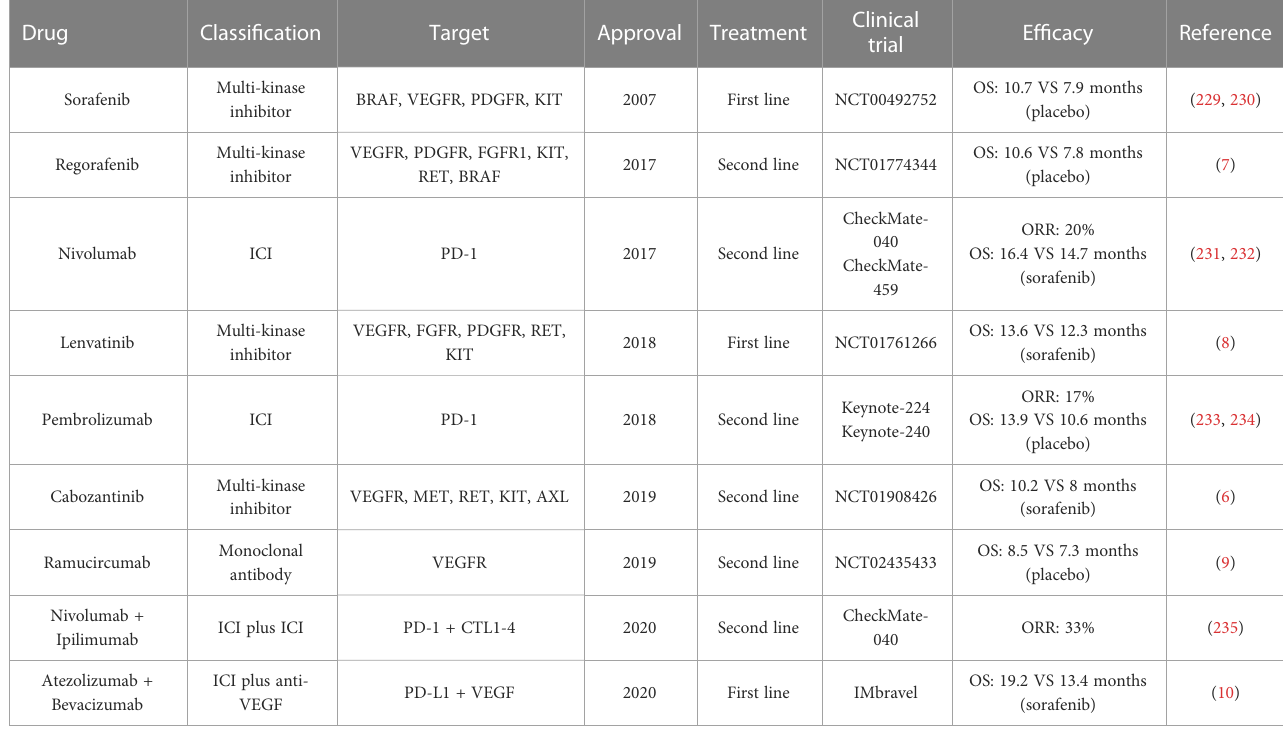
TABLE 2 FDA-approved drugs for hepatocellular carcinoma.